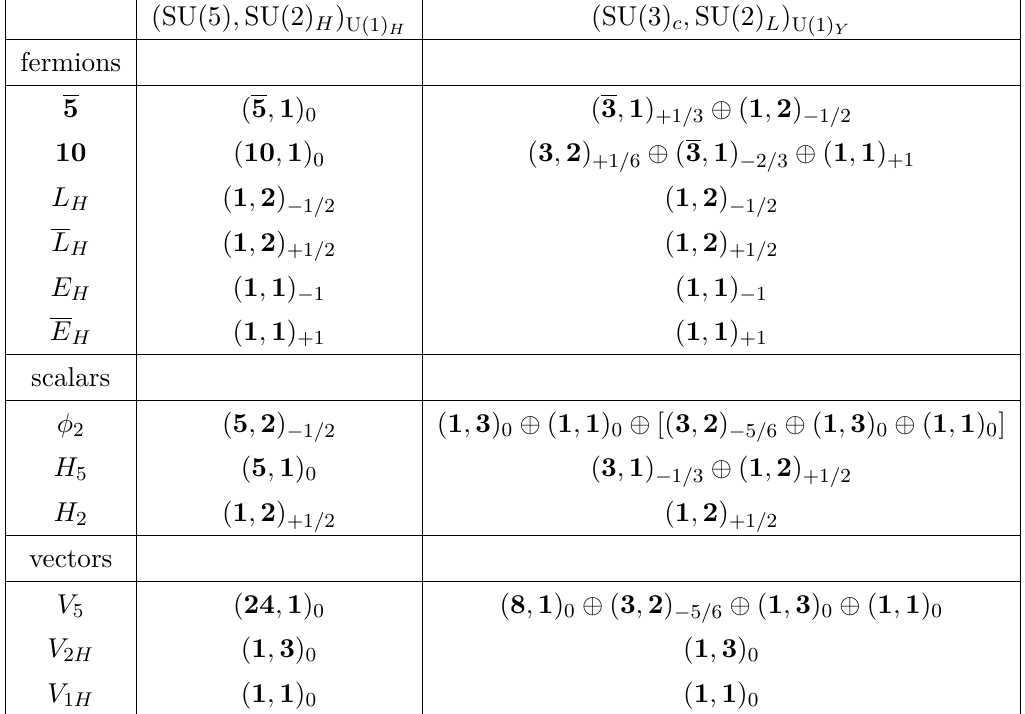
and (SU(3) c , SU(2) L ) . Each U(1) H U(1) Y